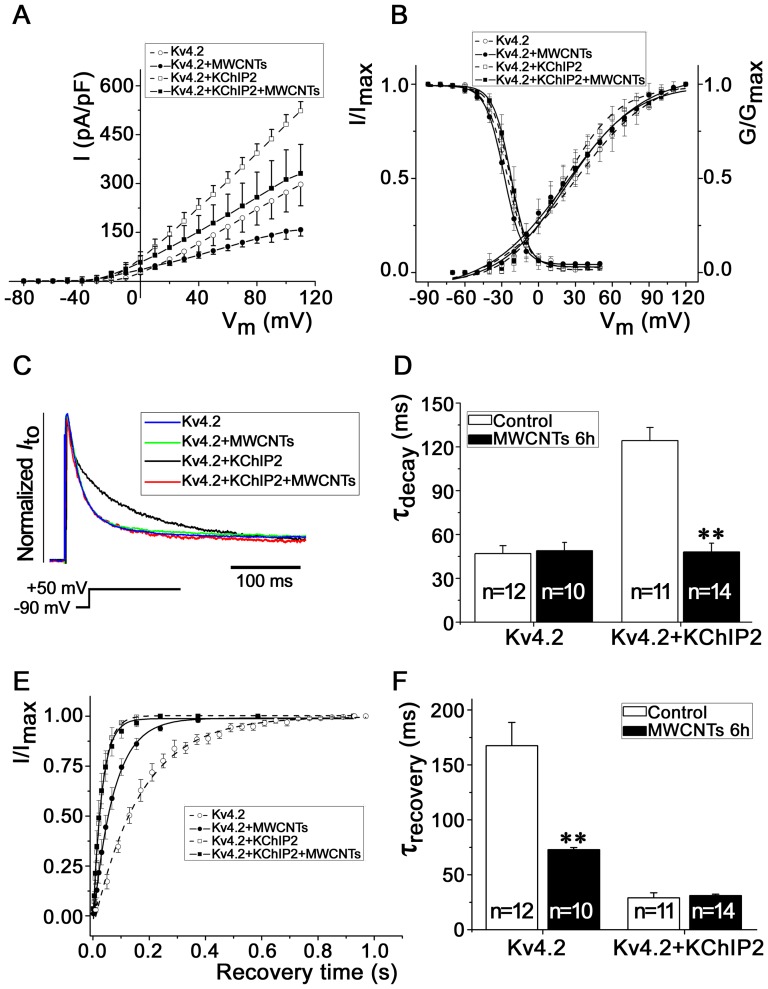
Effects of longer (6 h) exposure to MWCNTs on Kv4.2 channel kinetics in HEK293 cells.
A, I-V curves of I
Kv4.2 at different conditions. B, the voltage-dependent activation and inactivation curves fitted with Boltzmann equation. C and D, effects of MWCNTs on the decay kinetics of HEK293 cells expressing Kv4.2 with or without KChIP2. ** P<0.01 vs. control. E and F, the recovery curve and the statistical recovery time constant (τrecovery), respectively. **
P<0.01 vs. control.